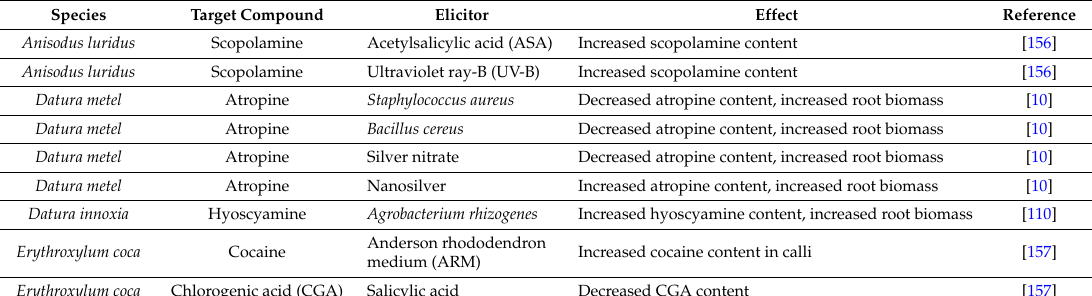
Table 3. A summary of recent metabolic engineering studies using